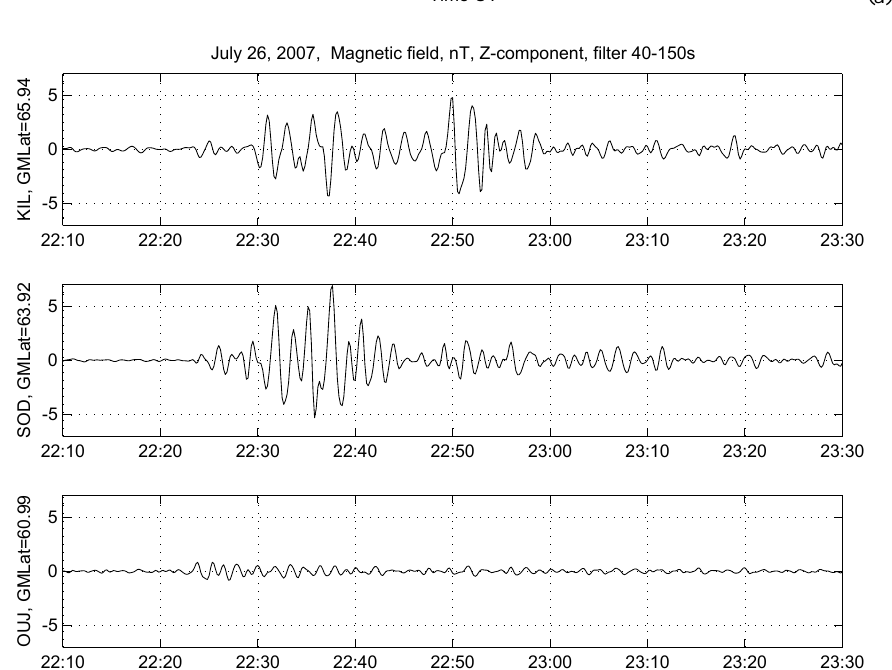
monochromatic Pc5 of smaller amplitude occur at auroral latitudes (around 70 ◦ GMLAT) (Engebretson et al.,